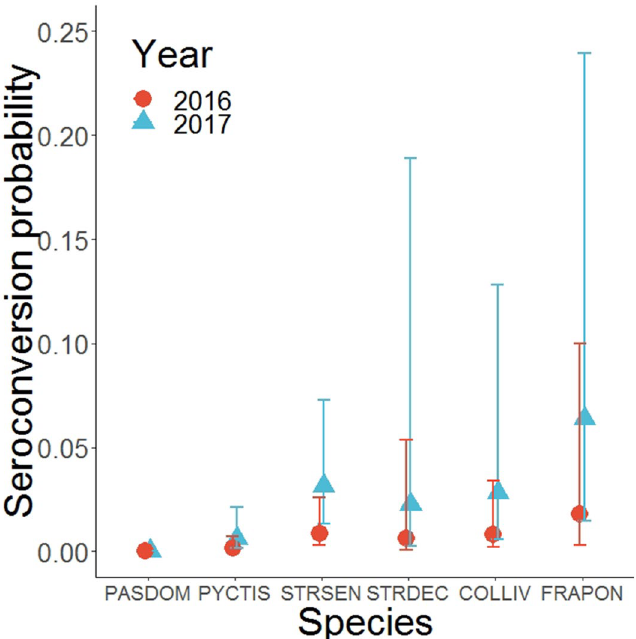
Figure 6. Weekly seroconversion probabilities for each bird species according to the year of sampling. PASDOM stands for Passer domesticus , PYCTIS for Pycnonotus leucotis , STRSEN for Spilopelia senegalensis , STRDEC for Streptopelia decaocto , COLLIV for Columba livia and FRAPON for Francolinus pondicerianus. Error bars represent 95% confidence intervals.